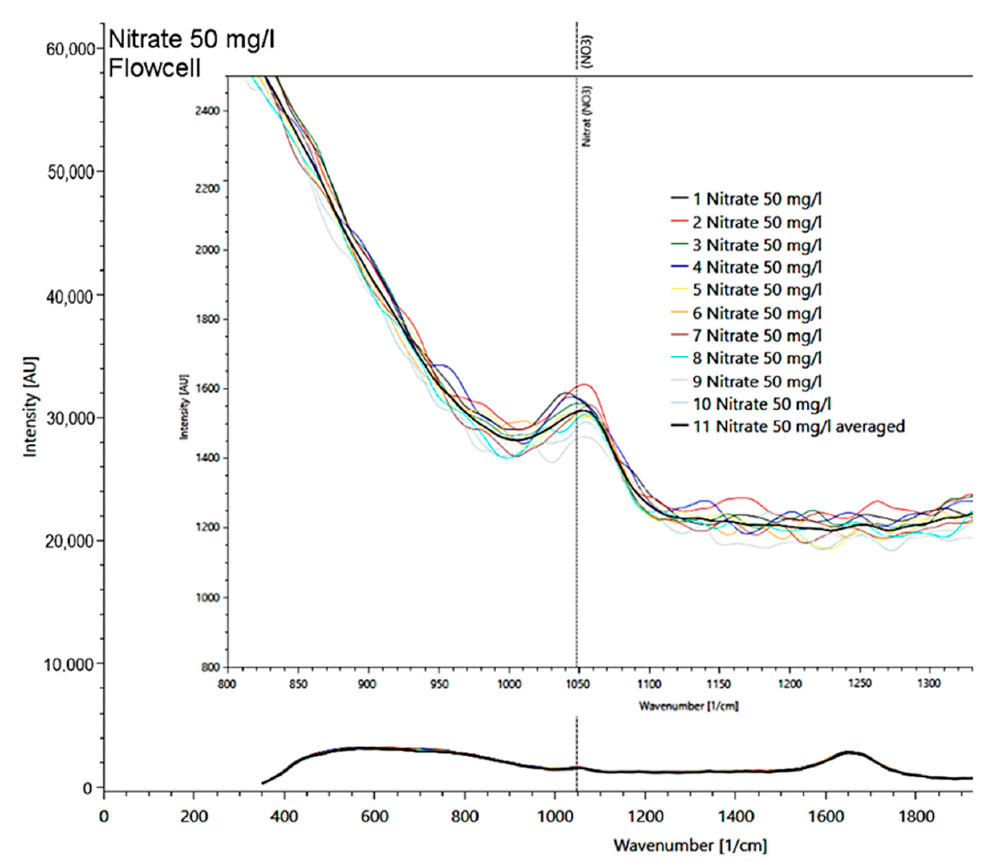
Figure 7. Presentation of the 50 mg/l nitrate spectrum measured in a flow cell with detail enlargement of the 10 measurement repetitions (multicolored lines; average as black line) at the reference signal at 1048 1/cm.